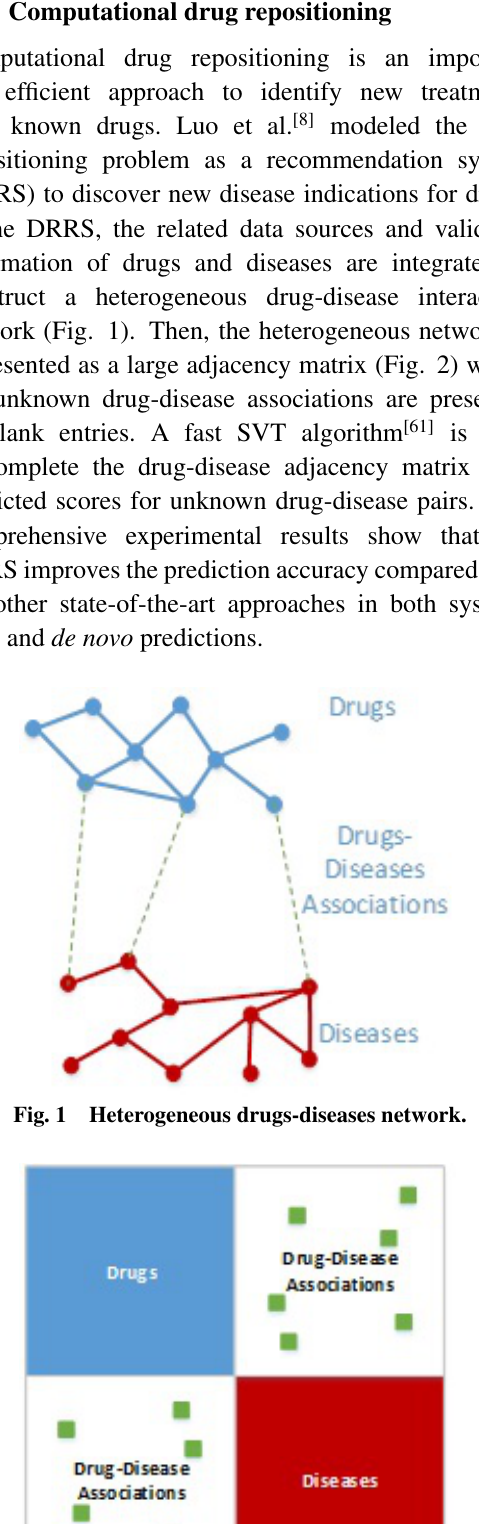
Fig. 3 Game matrix of 364 NCAA division I basketball teams. The x - and y -axes represent the NCAA teams and each point indicates there is a match between the two team during the regular